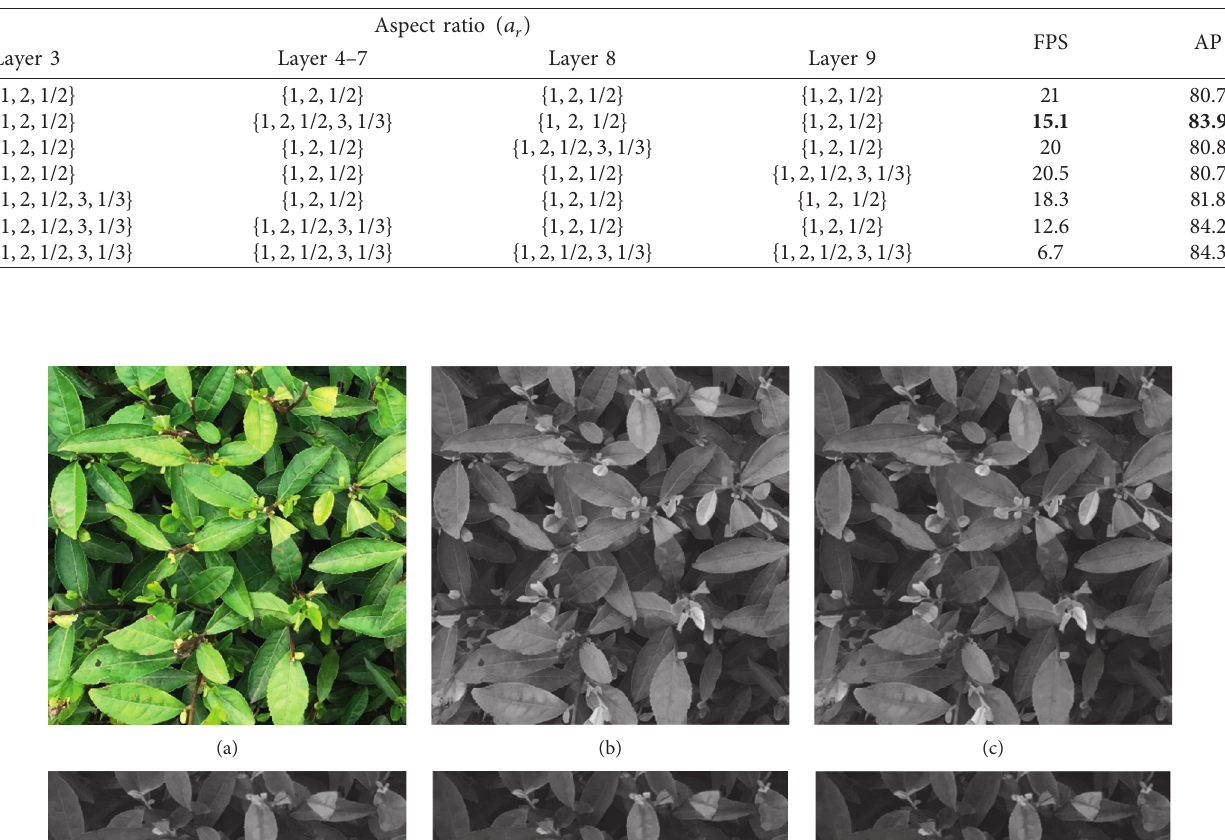
Table 4: Effects of aspect ratio for default boxes on FTSD-IEFSSD.